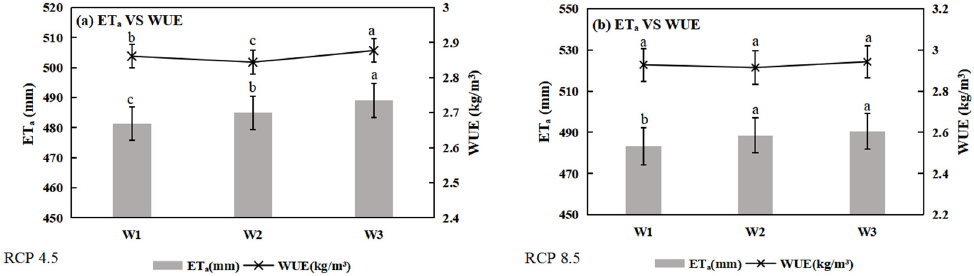
Figure 10. Relationship of WUE and ET a under different irrigation optimization schedules. Different lowercase letters represent different levels of each column at p ≤ 0.5.